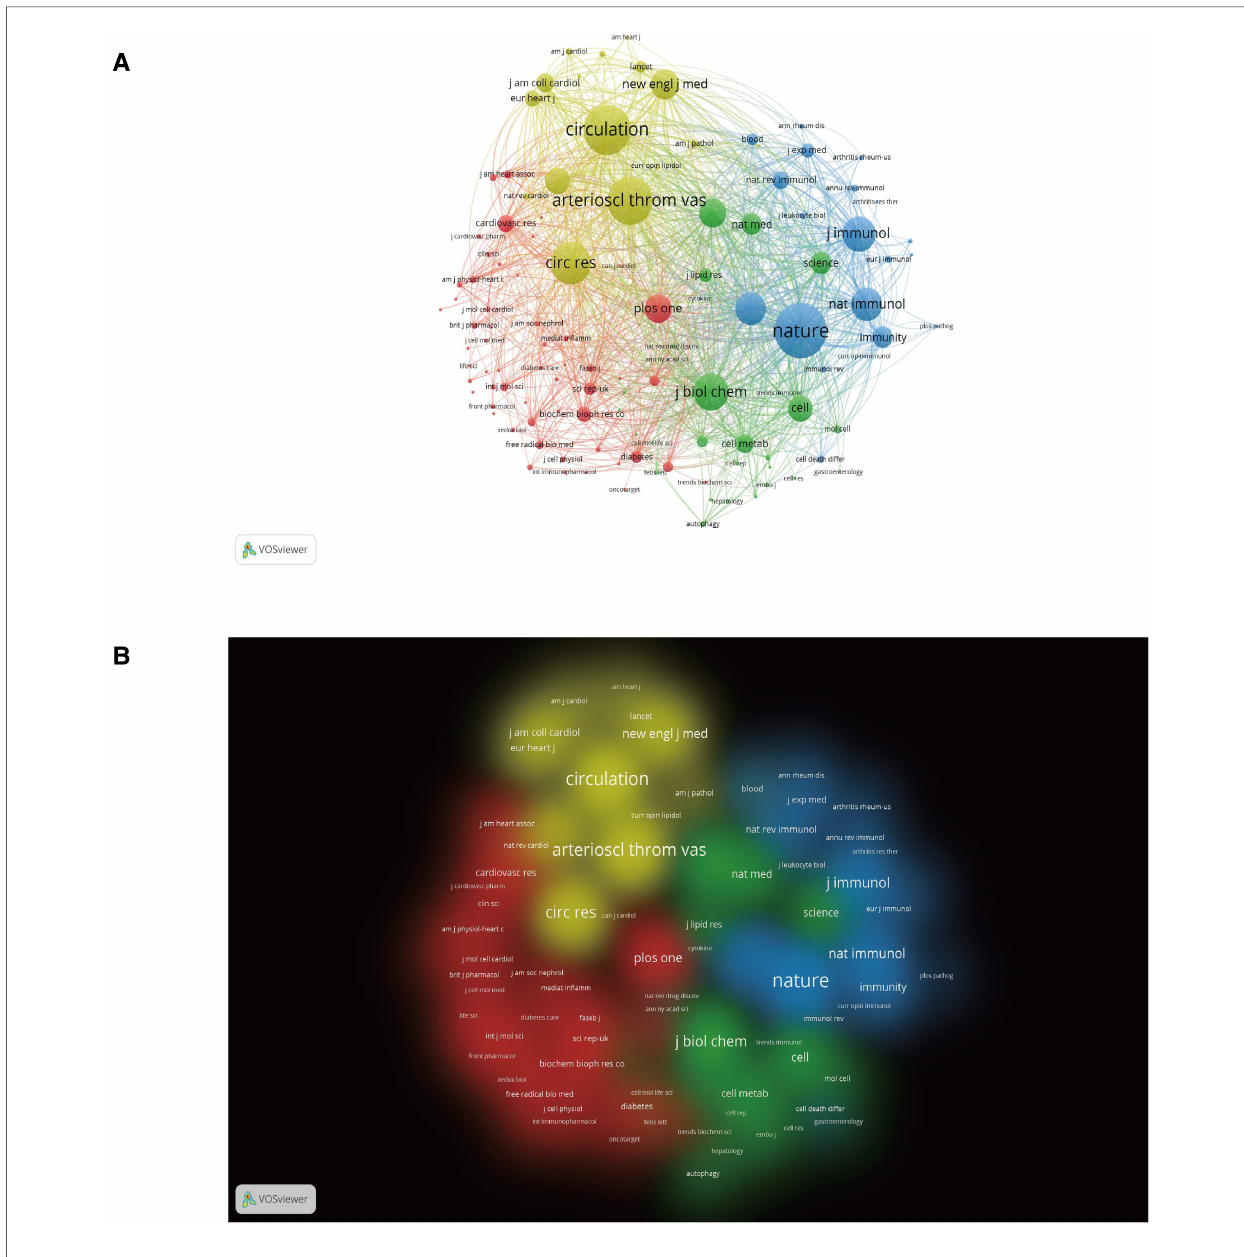
FIGURE 5 Analysis of cocited journals based on the VOSviewer visual map. ( A ) Network visualization; ( B ) Density visualization. Nodes on the map are colored according to their element